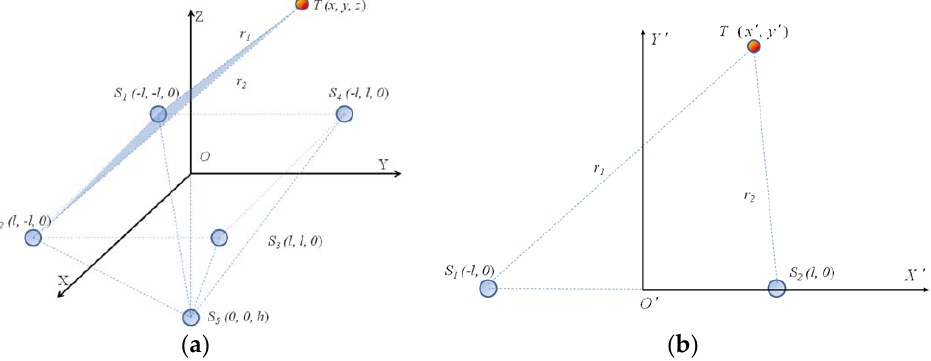
Figure 3. Schematic of coordinate transformation: ( a ) three ‐ dimensional (3D) coordinates and ( b ) two ‐ dimensional (2D) coordinates.